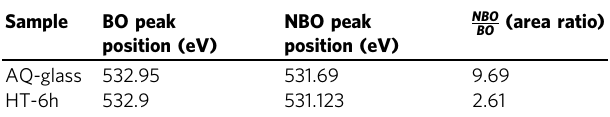
Table 1 BO and NBOs in AQ glass and HT-6h samples.